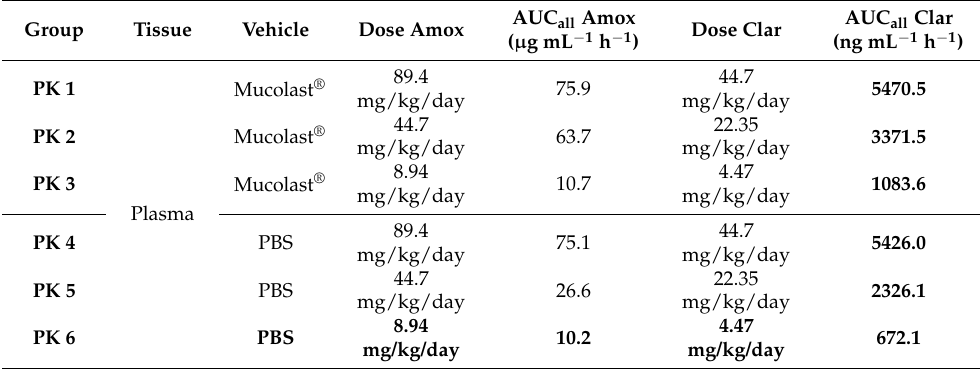
Table 5. Amox and Clar area under the curve (AUC) plasma values after the administration of antibiotics in Mucolast ® or saline solution at three different